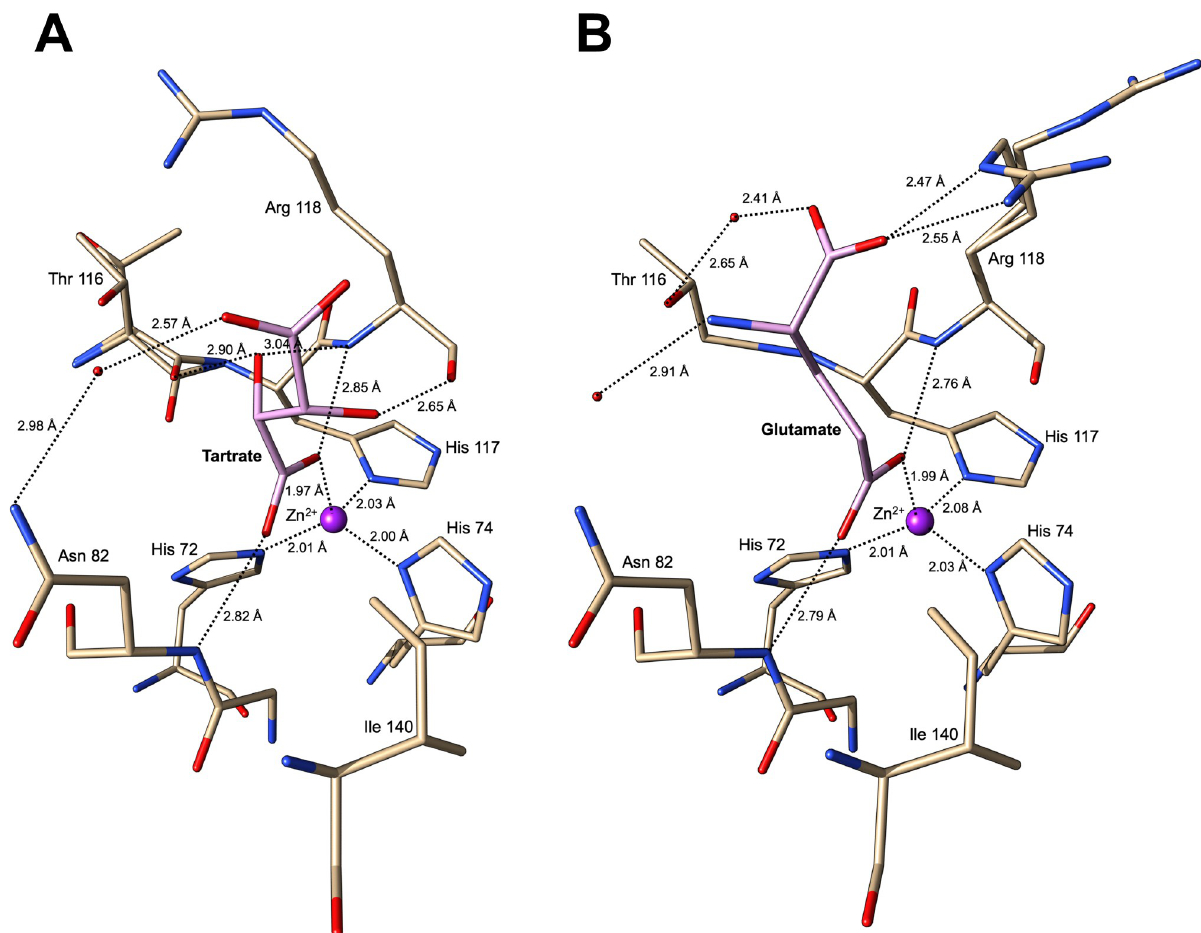
Fig 4. Close-up of the metal and ligand binding site in MrpH ntd . (A) MrpH 153 ligand binding site with tartrate bound. (B) MrpH 159 ligand binding site with glutamate bound. In both (A) and (B), residues interacting with the ligand or with the zinc ion are shown as sticks and labelled. Zinc is shown as a purple sphere. Water molecules are shown as red spheres. Hydrogen bonds and bonds to the zinc are shown as dotted lines with bond distances indicated next to the lines.